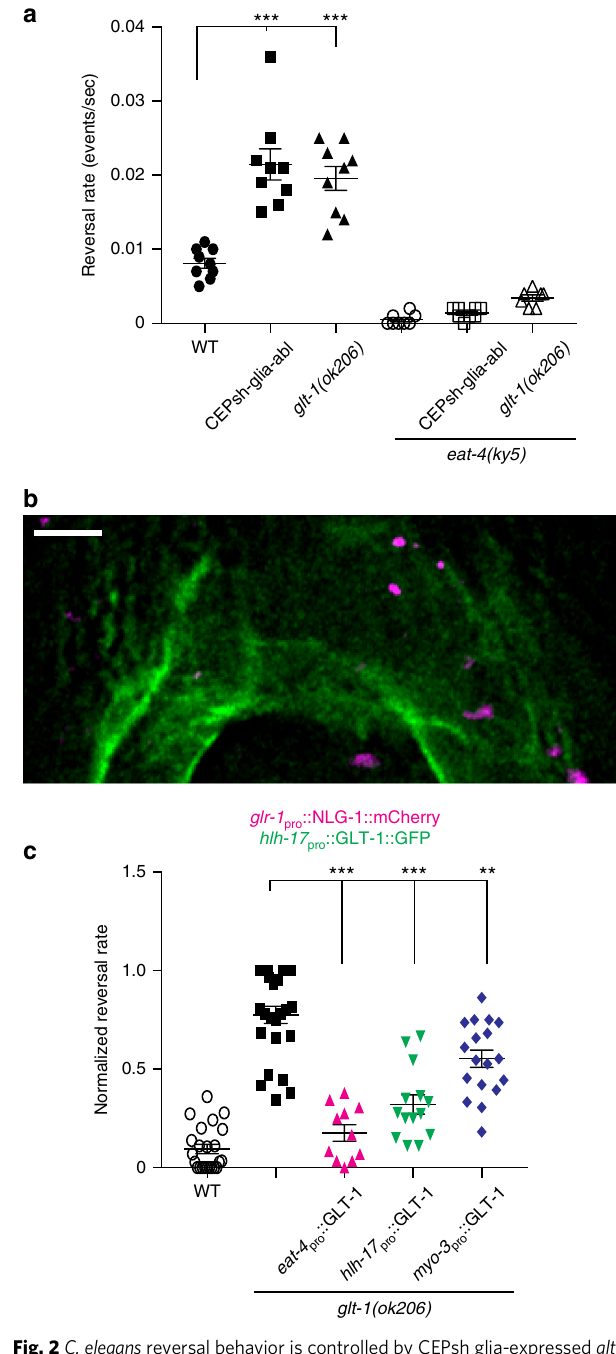
Fig. 2 C. elegans reversal behavior is controlled by CEPsh glia-expressed glt-1 . a Reversal rates in wild type (WT, black circles; n = 9 movies), CEPsh-glia- ablated (black boxes; n = 9 movies), glt-1(ok206) (black triangles; n = 9 movies), eat-4(ky5) (open circles; n = 8 movies), eat-4(ky5); CEPsh-glia- ablated (open boxes; n = 8 movies) and eat-4(ky5) ; glt-1(ok206) (open triangles; n = 7 movies) strains. b A deconvolved optical section. GLT-1 fused to GFP expressed in CEPsh glia using hlh-17 promoter. Synapses are marked by glr-1 pro ::NLG-1::mCherry. Scale bar, 4 μ m. c Cell-speci fi c glt-1(ok206) rescue studies. Reversal rates normalized relative to minimum value of WT controls and maximum value of glt-1 mutants. Wild type (WT, open circles; n = 23 movies), glt-1(ok206) (black boxes; n = 25 movies), GLT-1 transgene expressed in neurons (magenta triangles; eat-4 ; n = 11), CEPsh glia ( hlh-17 , green triangles; n = 14), muscles ( myo-3 , blue diamonds; n = 18). a , c Bars, mean±SEM, ANOVA Tukey ’ s HSD post hoc test, ** p <0.005, *** p <0.0005. Source data are provided as a Source Data fi